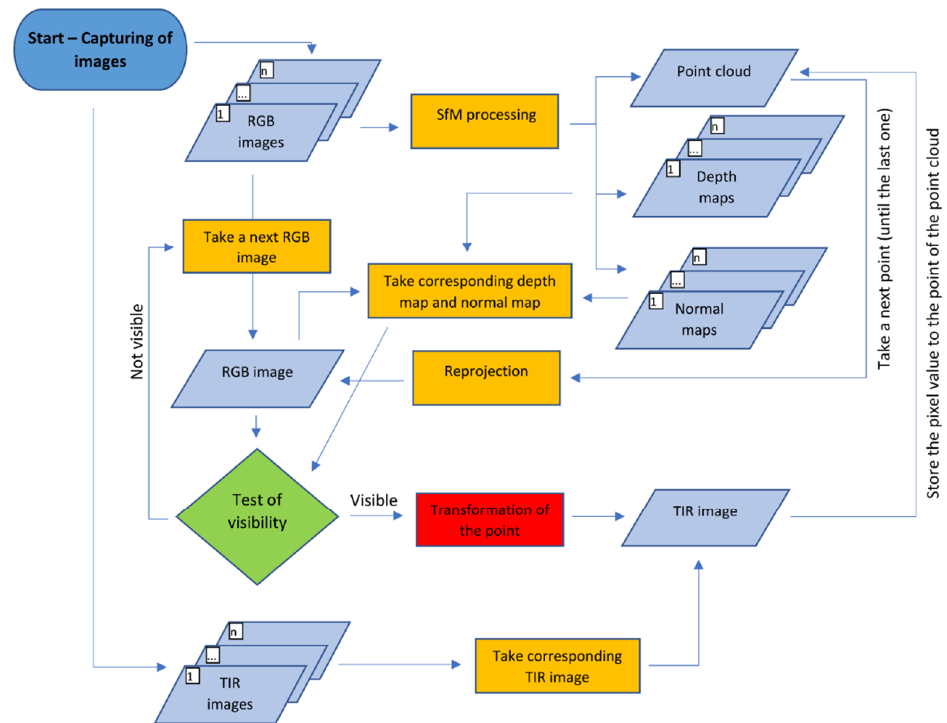
Figure 3. Diagram of the Reprojection method.